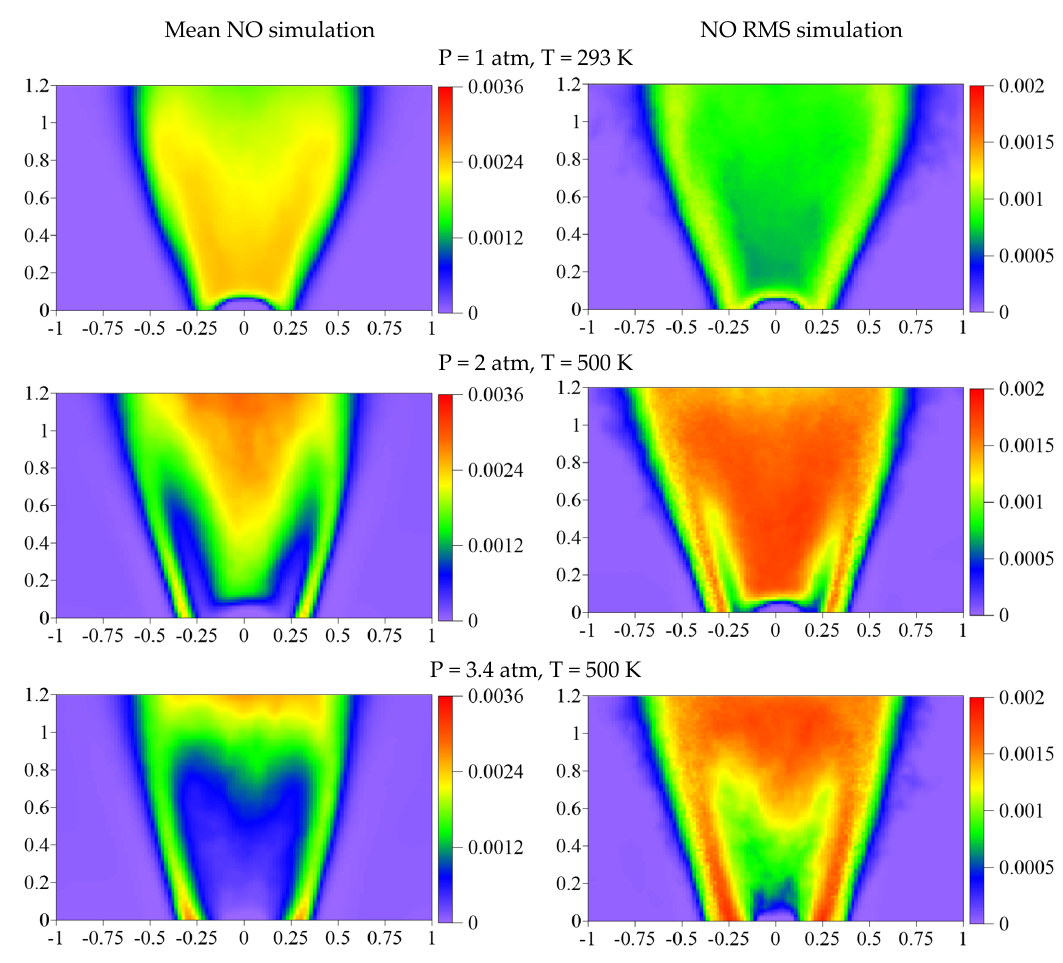
Figure 9. Mean NO concentration fields and RMS of the concentration fluctuations evaluated by the LES approach.